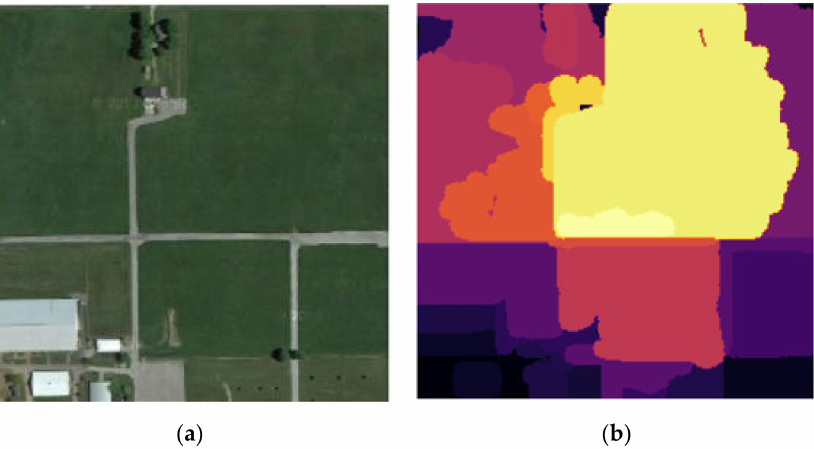
Figure 8. ( a ) Original image. ( b ) XRAI shows the image feature hot